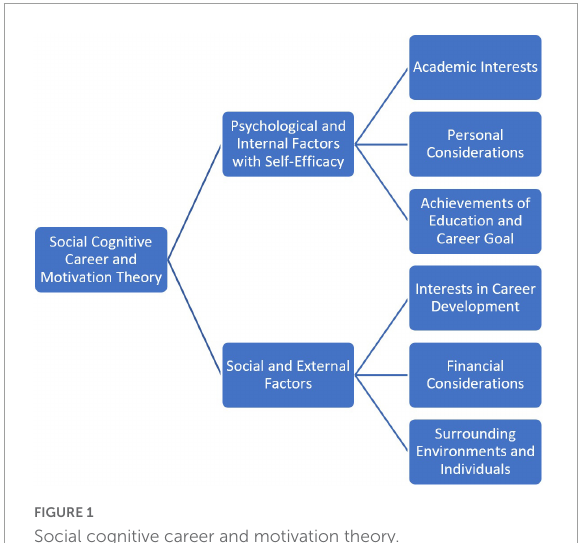
FIGURE1 Social cognitive career and motivation